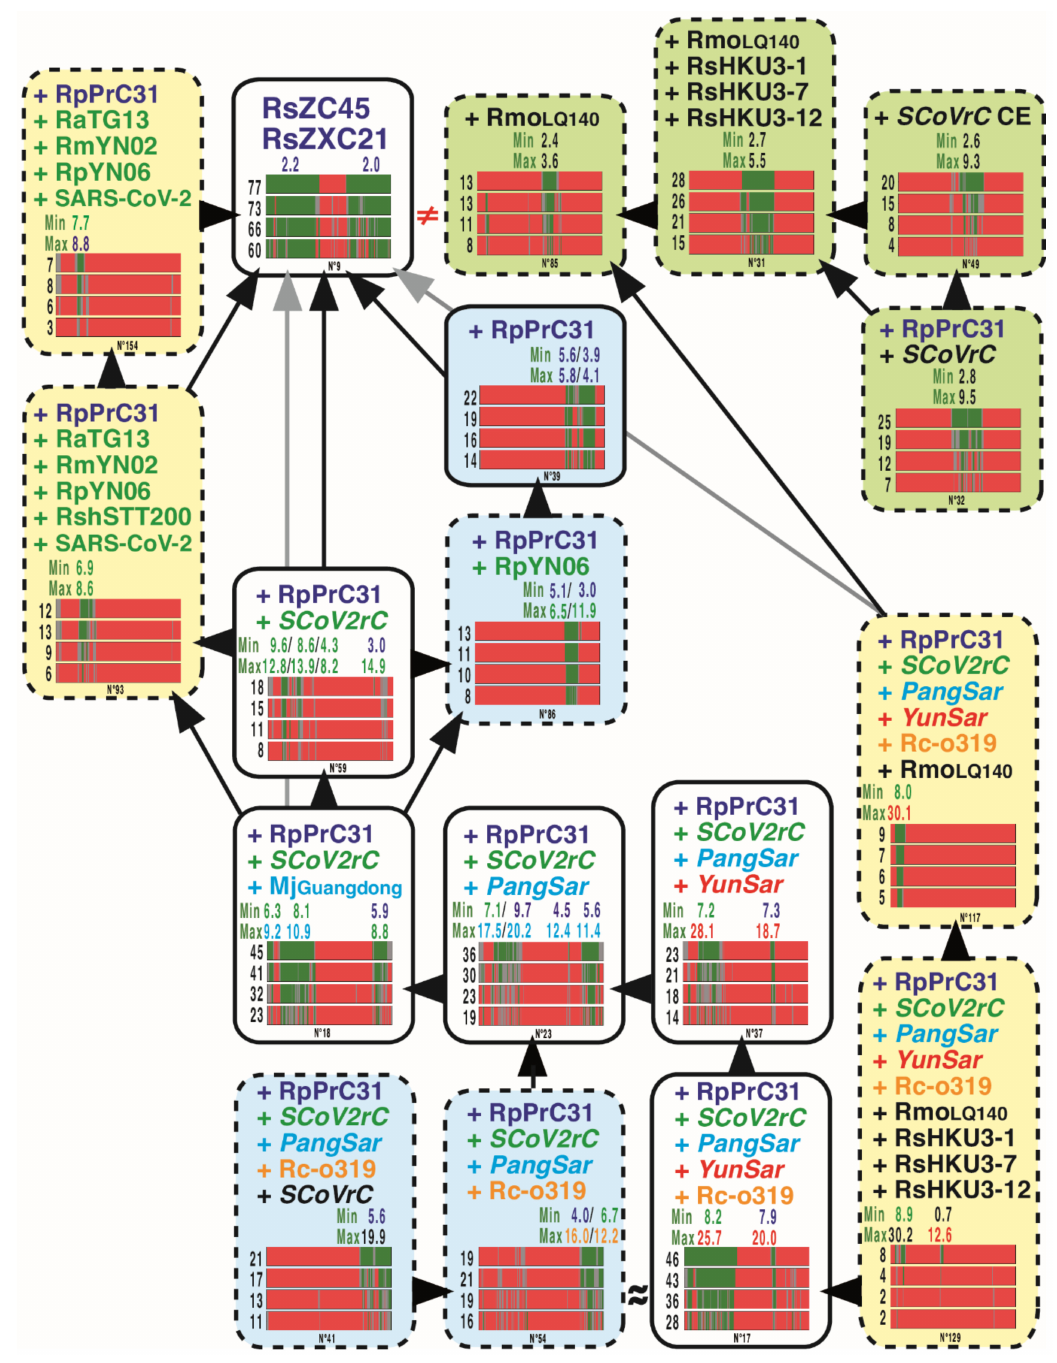
Figure 5. Genomic bootstrap (GB) barcodes generated for the bipartitions including RsZC45 and RsZXC21. The GB barcodes are shown for the 18 bipartitions including RsZC45 and RsZXC21 found in the SWB analyses based on four window sizes (250, 500, 1000, or 2000 nt) and supported by MBP 2000 > 7%. For more details on GB barcodes, read the legend of Figure 4. Here, the GB barcodes with MBP 2000 < 7% were not